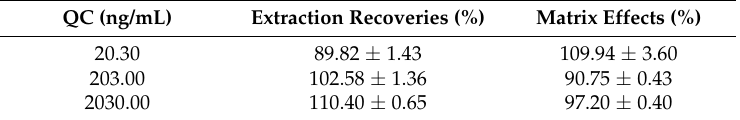
Table 3. Extraction recoveries and matrix effects of Nec-1s in rat plasma (mean ± SD, n =